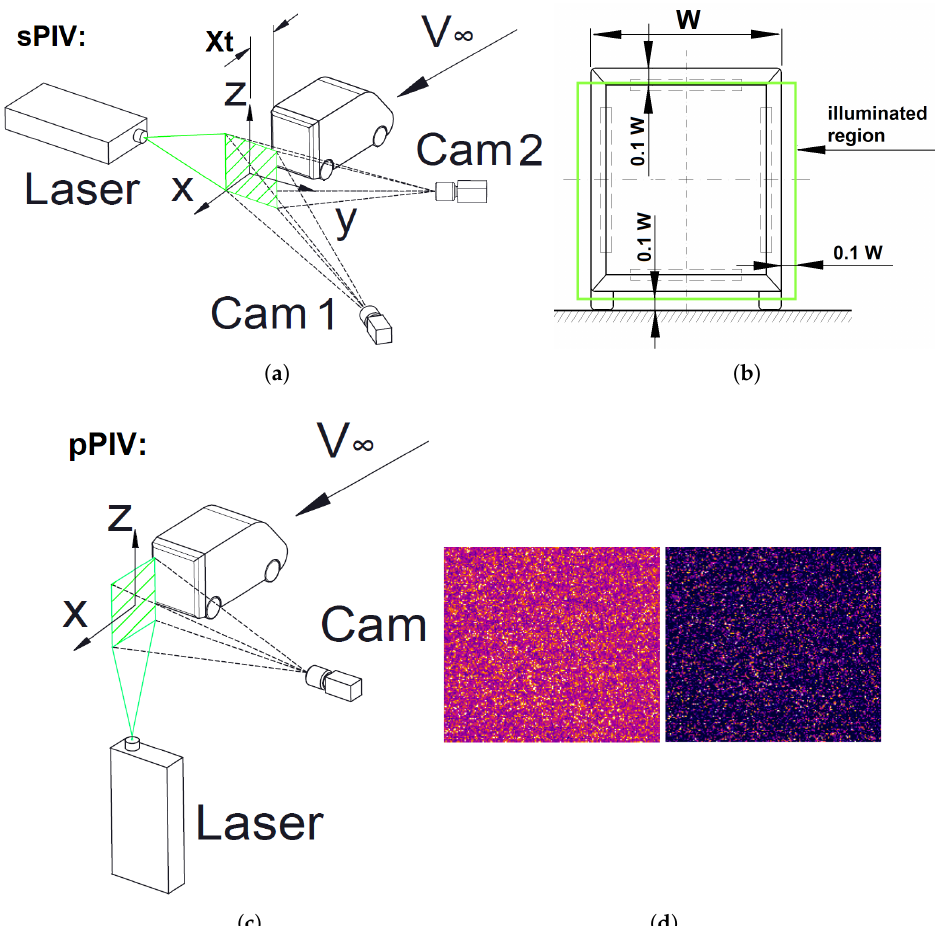
Figure 3. ( a ) Schematic representation of the sPIV system with indication of the imaged planes location. The investigated planes are Xt / W = 0.82, 0.91, 1, 1.09, 1.18, 1.26, and 1.35. ( b ) Detail of the illuminated region and spatial location with respect to the model’s rear face. ( c ) Schematic representation of the pPIV system with indication of the imaged planes location. ( d ) Comparison between raw (left) and preprocessed (right) image after historic minimum